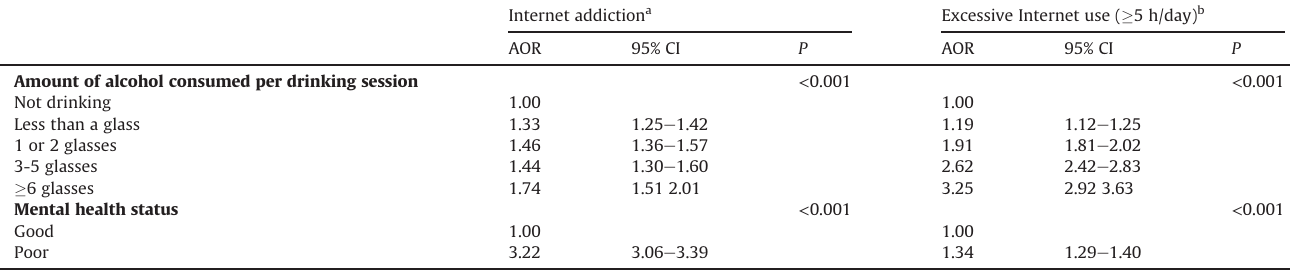
Internet addiction